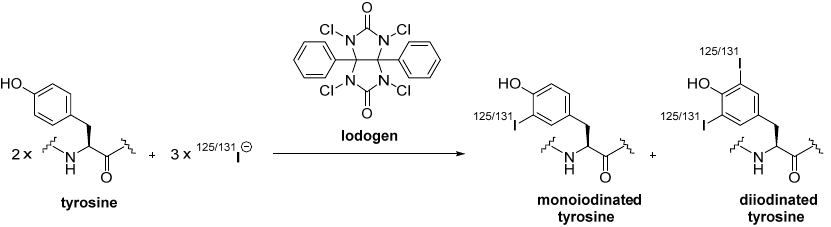
Figure 3. Installation of iodine-125 or iodine-131 into tyrosine residues of proteins and peptides via Iodogen